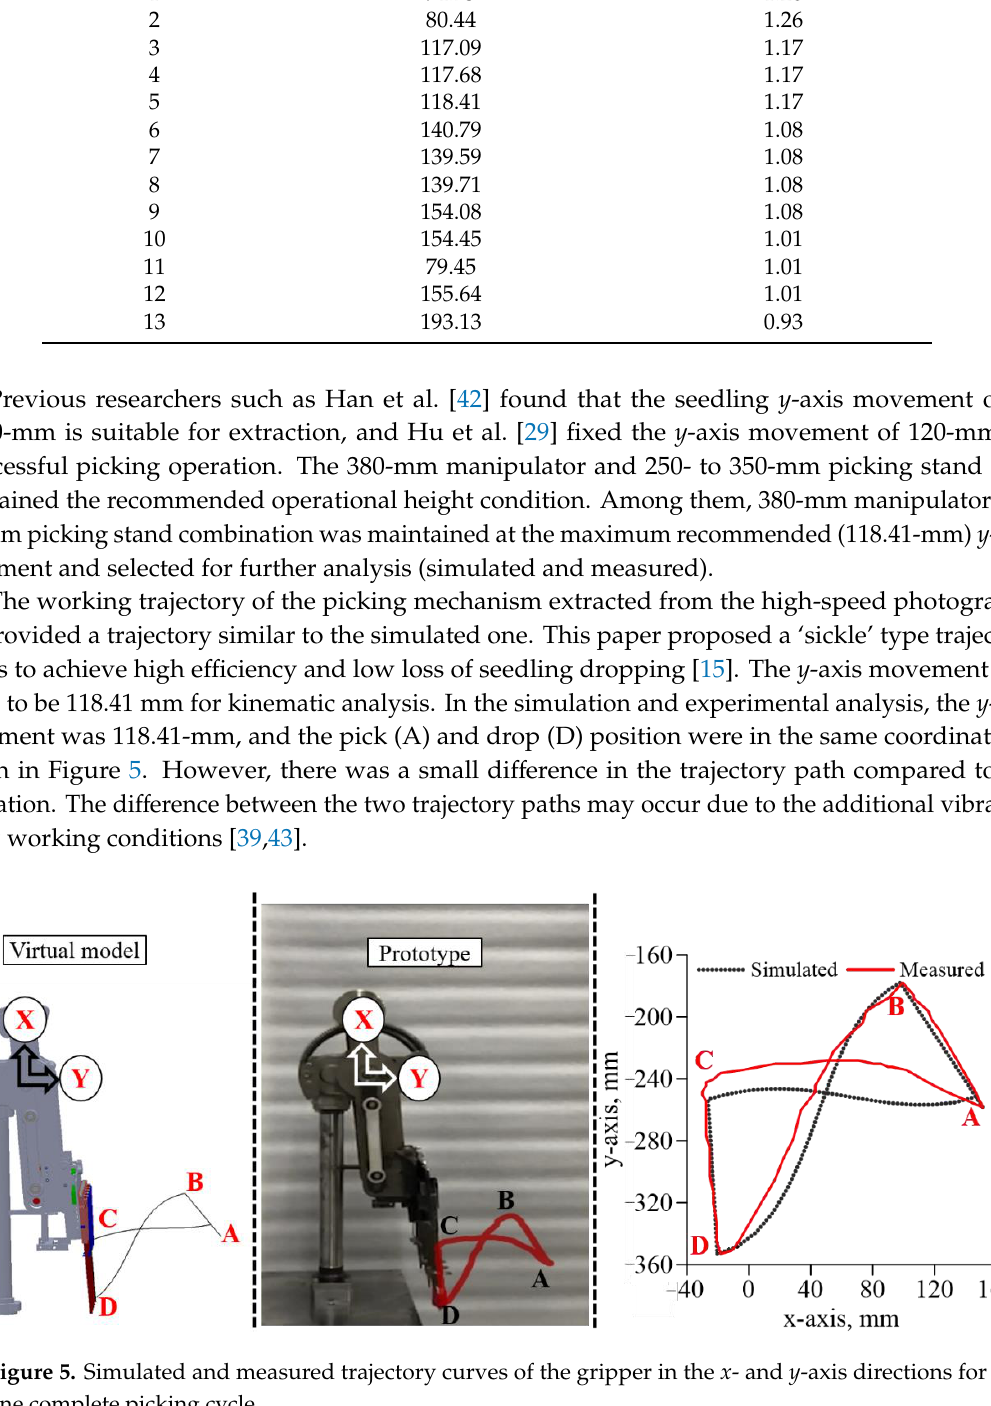
Table 5. Position analysis results based on the various dimensions of the picking device bars